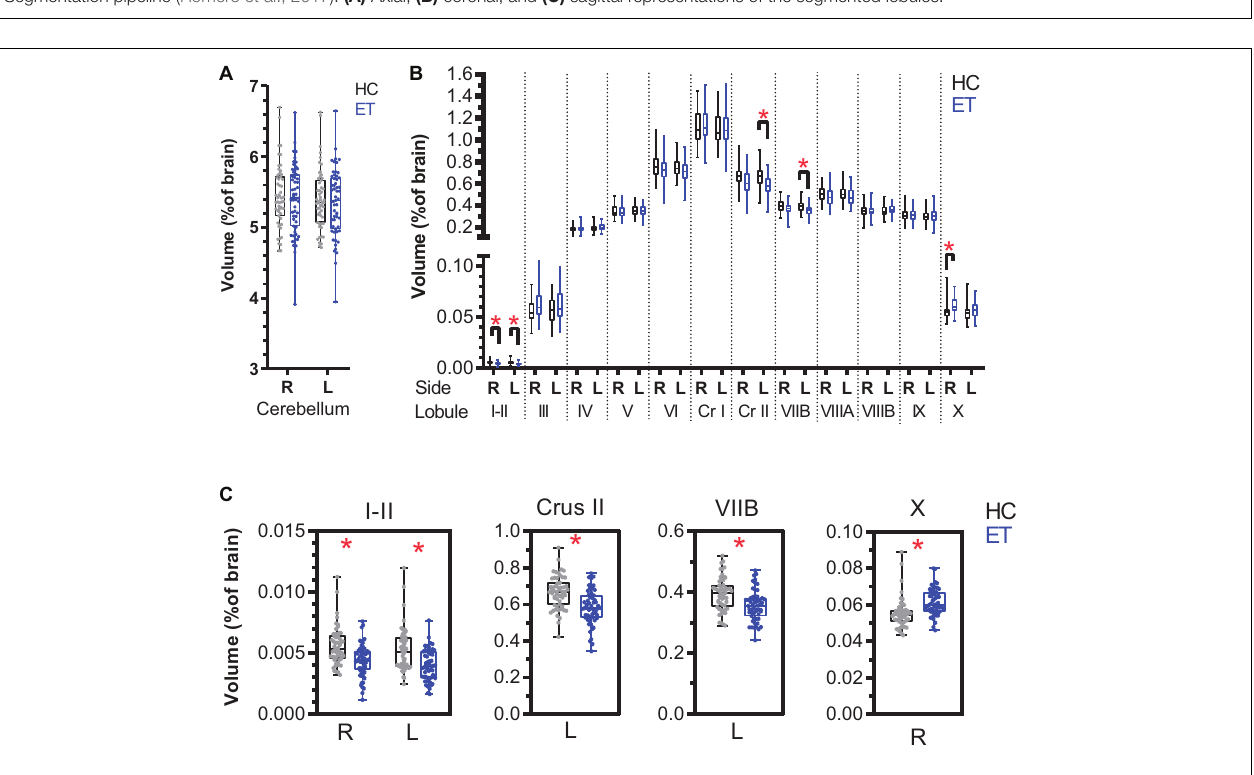
FIGURE 2 | Normalized cerebellar lobule volumes in patients with essential tremor (ET) and in healthy controls (HCs) expressed as percentage of total brain volume. (A) Right and left cerebellar lobule volumes for the HC (black) and ET (blue) groups. (B) Lobule volumes for the right and left cerebellar hemispheres. (C) Lobules with significant volume differences between the HC and ET groups: bilateral I-II, left Crus II, left VIIB, and right X ( Table 2 ). The boxplots show the 25th, 50th, and 75th percentiles for all data. A multivariate general linear model was applied to the cerebellum and the 12 lobules (right and left sides) with gender, age, and total brain volume as covariates. The significance level ( p < 0.05) was adjusted for multiple testing using the Benjamini-Hochberg method. Significance is denoted by *. R: right, L: left, Cr I: Crus I, Cr II: Crus II.